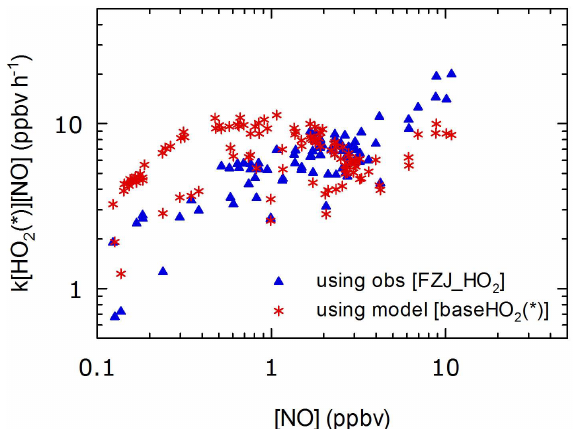
Fig. 10. HO 2 (*)+NO reaction rates derived from HO 2 observed by FZJ instrument (blue triangles), and HO 2 (*) modeled by the Base run (red stars) plotted as a function of NO. Only midday (09:00– 15:00UTC) data are